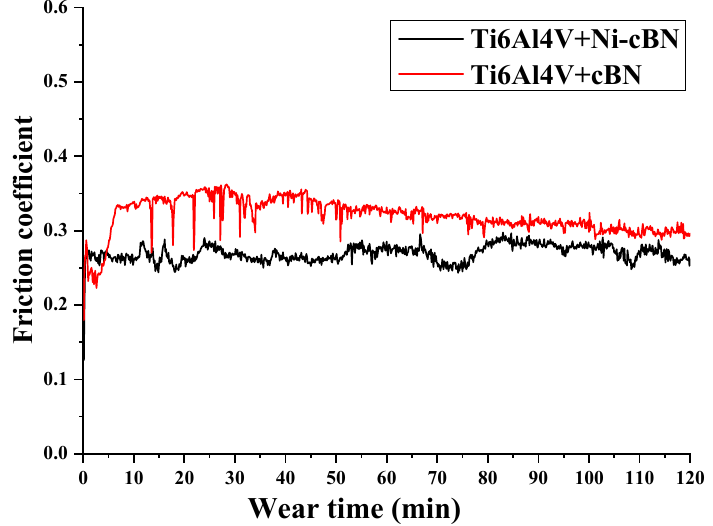
Figure 9. Variations of the friction coefficient with a sliding time range.